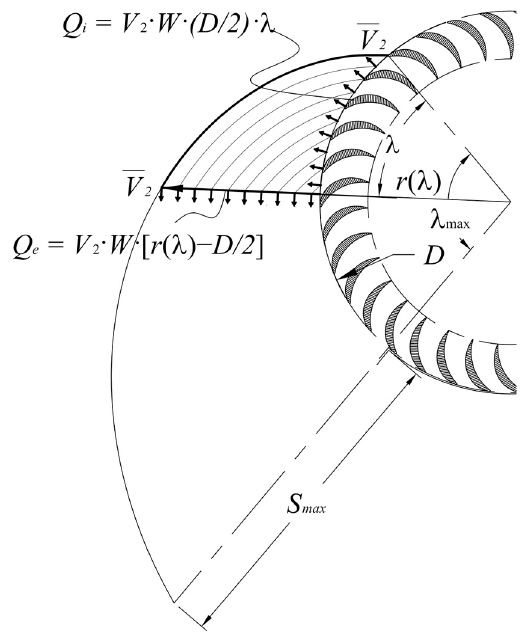
Figure 6. Section view only of the first diffuser part.